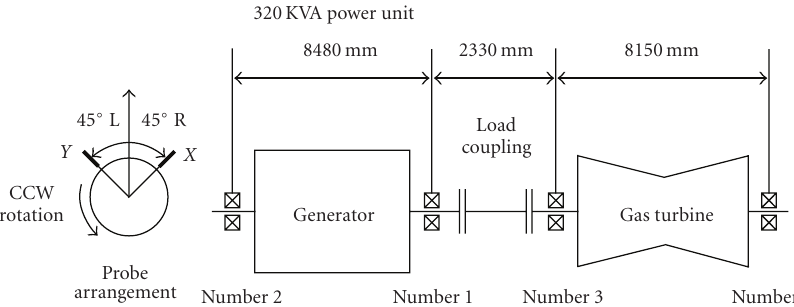
Figure 1: Machine-train diagram of the power unit, bearing numbers, and probe arrangement.